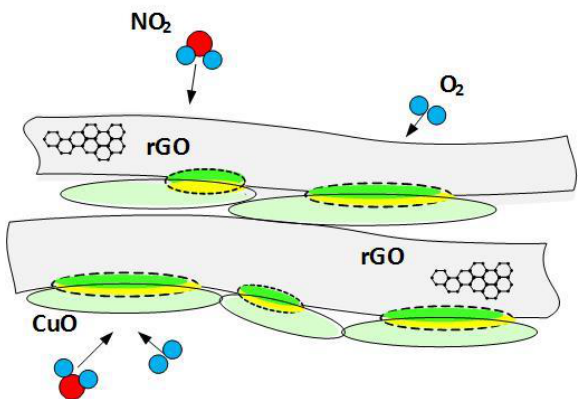
Figure 13. Multilayer rGO/CuO. Possibility of heterojunction formation is shown.